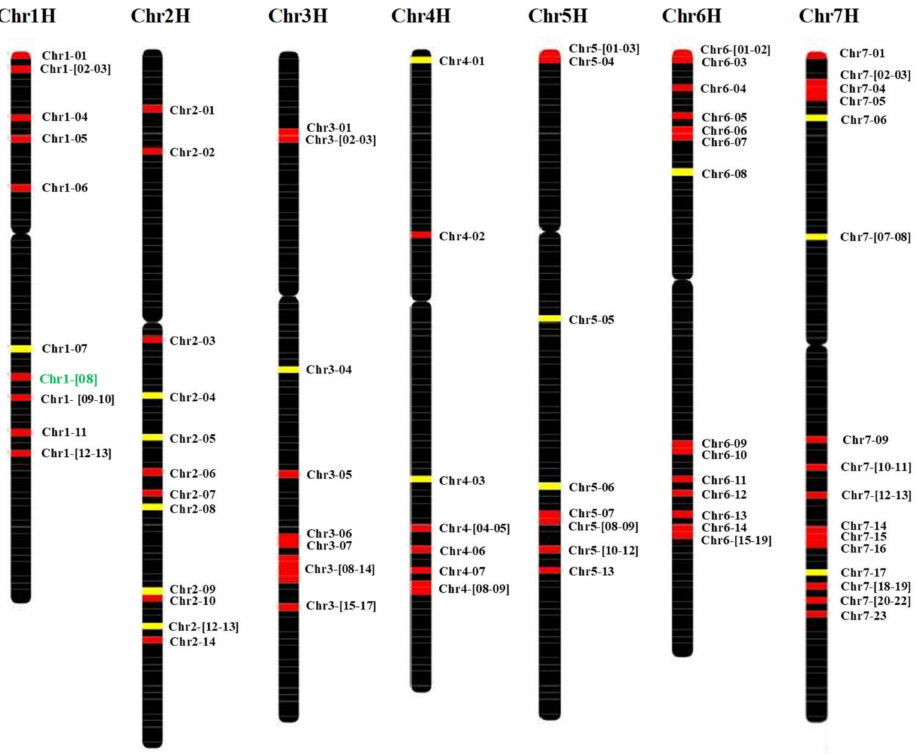
Figure 2. Genetic map of the HvMADS-box genes. The map includes all seven barley chromosomes. Genes are indicated to the right of each interval position. High confidence (HC) genes are marked with red, while low confidence (LC) genes are colored with yellow. HvMADS56 is in green (Chr1-08). Full name of each gene is given in Table